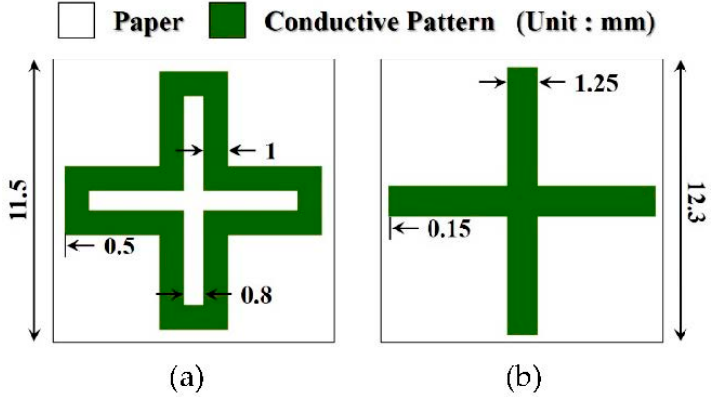
Figure 2. Proposed frequency selective surface unit cell: ( a ) Loop type; ( b ) Patch type.